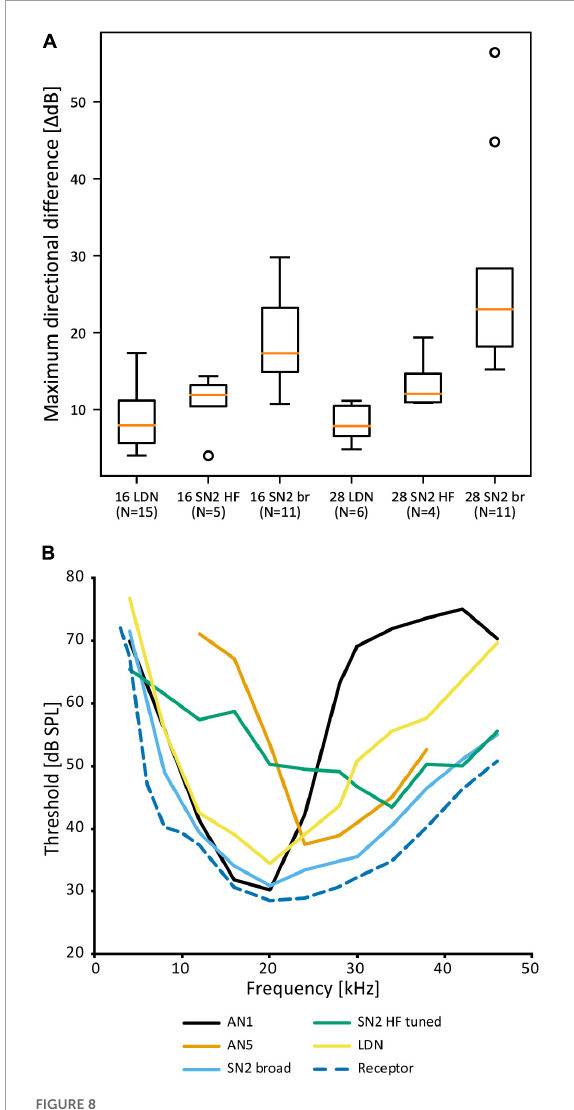
FIGURE8 Comparison of SN2 and LDN to other neurons in A. nigrovittata . (A) Box plot (median in orange, lower and upper quartile; whiskers represent the minimum/maximum value within 1.5 times the interquartile range; outliers shown as circles) of the maximum difference in dB between the responses to ipsilateral and contralateral stimulation measured within the dynamic range of intensity scans as shown in Figures 7D,E . 16 and 28 represent the tested carrier frequencies in kHz; SN2 are divided as “broad” (br) and ”HF-tuned” (HF). (B) Frequency thresholds of LDN and SN2 in comparison to the overall hearing threshold (minimal values from auditory receptor neurons; see Ostrowski and Stumpner, 2010) and that of the spikes of the ascending neurons tuned best to the male song (AN1, mean of 21–23 (30 kHz: 10) males and females) or tuned best to the female song (AN5-AG7, mean of 4–8 males; see Stumpner and Molina,